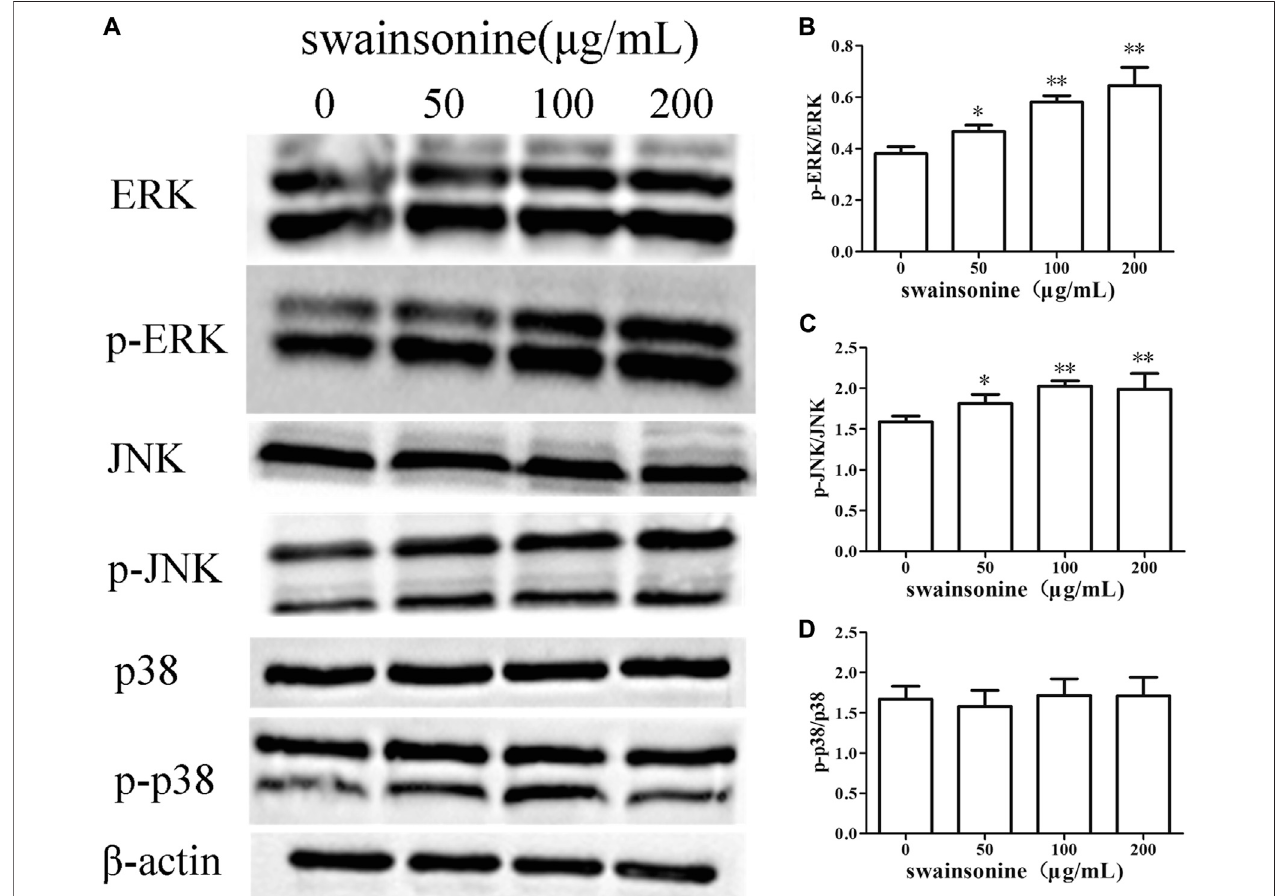
FIGURE9| SWincreases theexpression ofproteins involvedintheMAPKcascadeinRTECs (A) TheproteinslevelschangesofERK,JNKandp38wereanalyzed by the Western blotting analysis of cells treated with a range of concentration of the SW for 24 h (B – D) These column charts show the ratio of p-ERK/ERK, p-JNK/JNK, p-p38/p38. Three independent experiments were performed. Statistically signi fi cance was indicated: * p < 0.05, ** p < 0.01 compared with control.